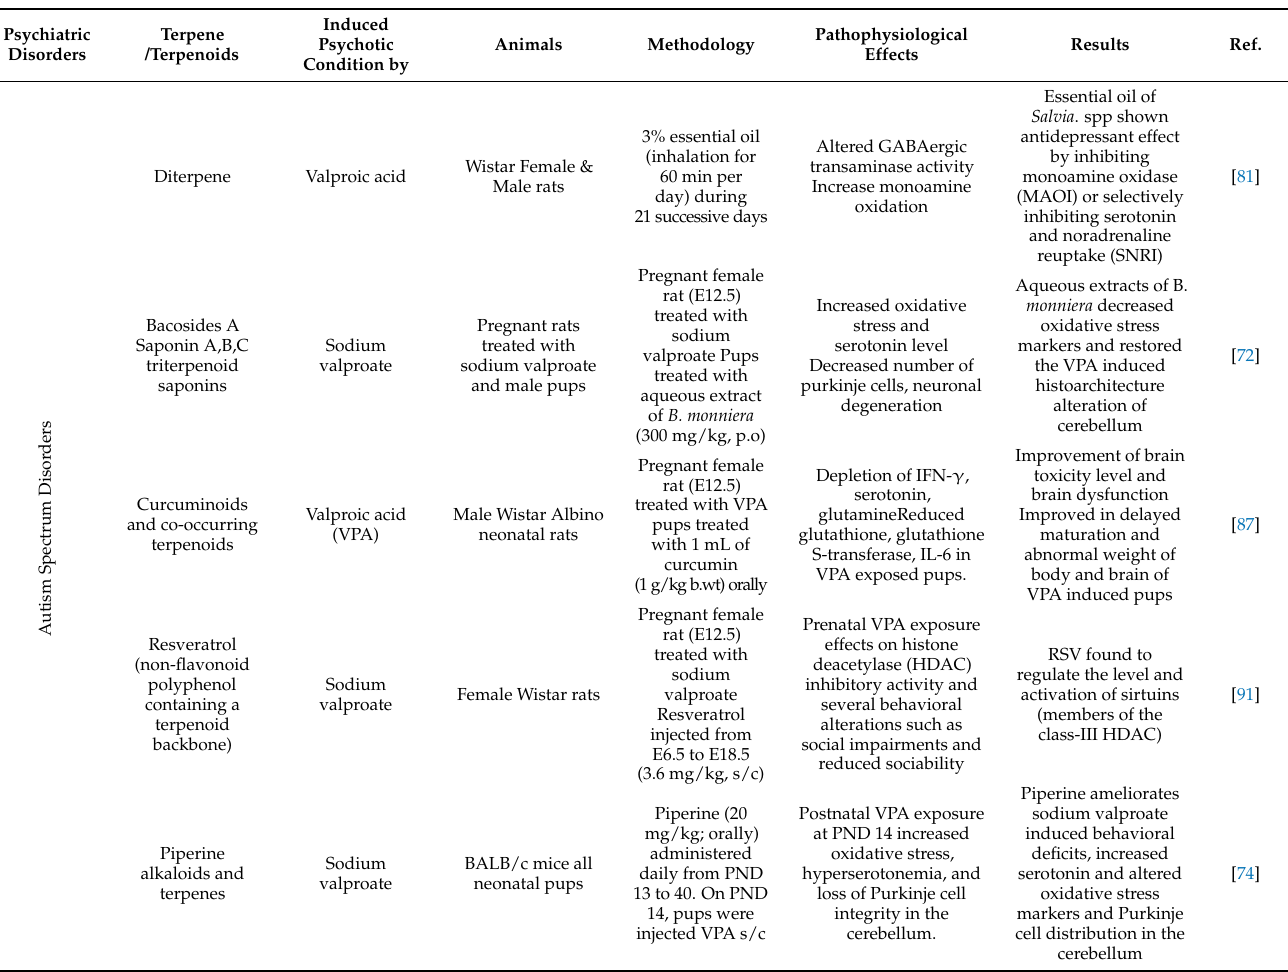
Table 2. Effects of terpenes or terpenoids in the preclinical studies of psychiatric